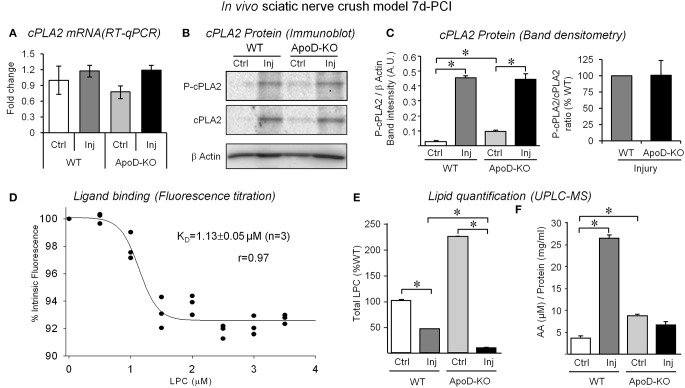
Analysis of cPLA2 expression, LPC binding to ApoD, and quantification of LPC and free AA in the nerve upon injury. (A) Quantitative RT-PCR of cPLA2 group IVA shows no differences in ApoD-KO nerves 7d-PCI. (B,C) Immunoblot analysis of phospho-cPLA2 and total cPLA2 in intact nerves and in the region distal to the lesion. Neither the induction of cPLA2 protein expression upon injury nor its phospho-cPLA2/total cPLA2 ratio is ApoD-dependent. Protein band intensities were normalized to β-actin. (D) Relative fluorescence intensity of hApoD exposed to increasing concentrations of lysophosphatidylcholine (LPC). Dots represent the mean of 3 independent titrations. (E,F) Mass spectrometry analyses of LPC (E) and free arachidonic acid (AA) (F) in intact nerves and in the injury region of WT and ApoD 7d-PCI nerves. Statistical differences were assayed by Mann-Whitney U-test (A), and Student's t-Test (C–E). Asterisks show statistically significant differences (P < 0.05).